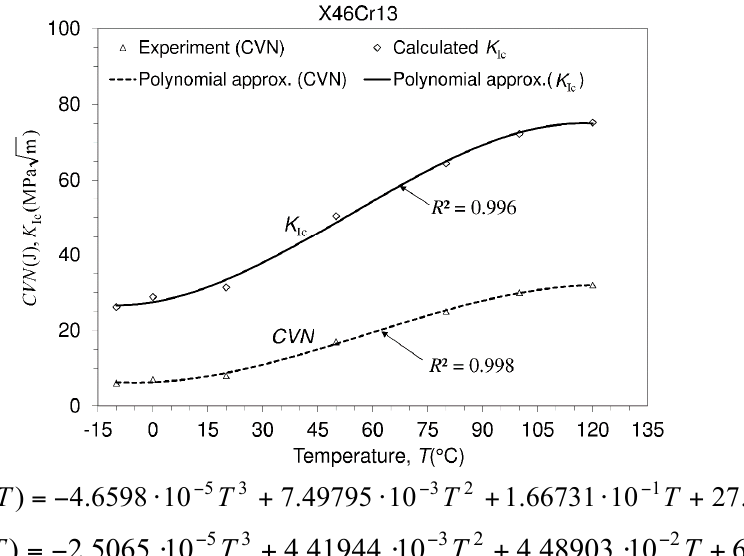
Figure 10. Although the Charpy tests are much simpler, the results obtained by the fracture toughness tests are much more reliable. However, fracture toughness testing is also a laboratory method.